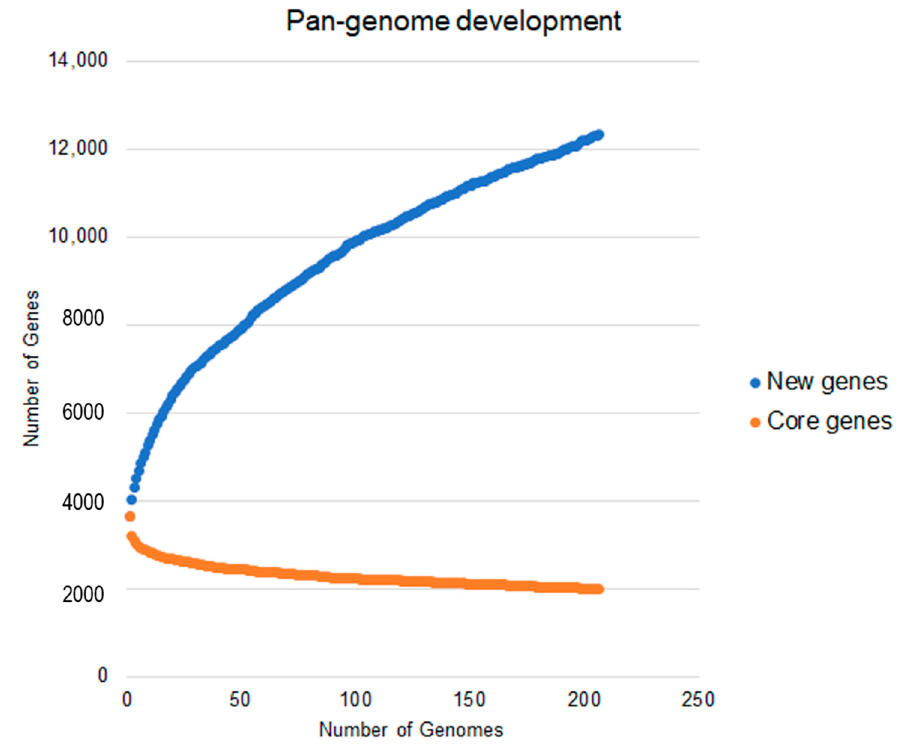
Figure 4. Development curve of the pan-genome of Acinetobacter baumannii .